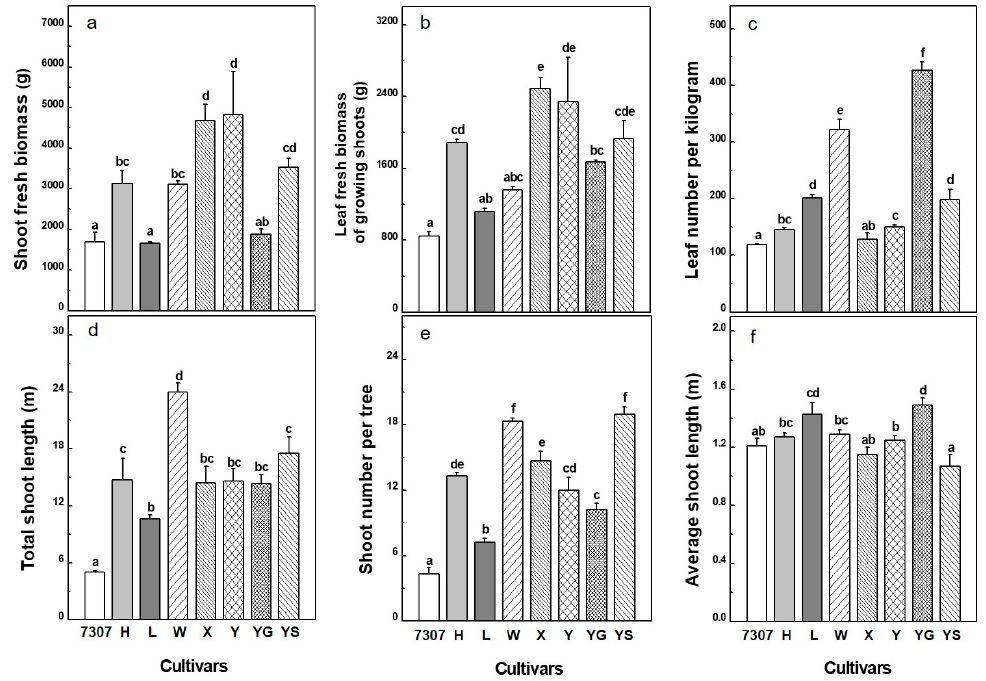
Figure 1. Shoot biomass-related agronomic attributes including shoot fresh biomass ( a ), leaf fresh biomass of growing shoots ( b ), leaf number per shoot ( c ), total shoot length ( d ), shoot number per tree ( e ), and average shoot length ( f ) of the eight 3-year-old mulberry cultivars: 7307, Husang32 (H), Liaolu11 (L), Wupu (W), Xiang7920 (X), Yu711 (Y), Yunguo1 (YG), and Yunsang2 (YS). For each cultivar, the presented data are the means ± SE (n = 3–4). Di ff erent letters on the error bar indicate significant di ff erences between